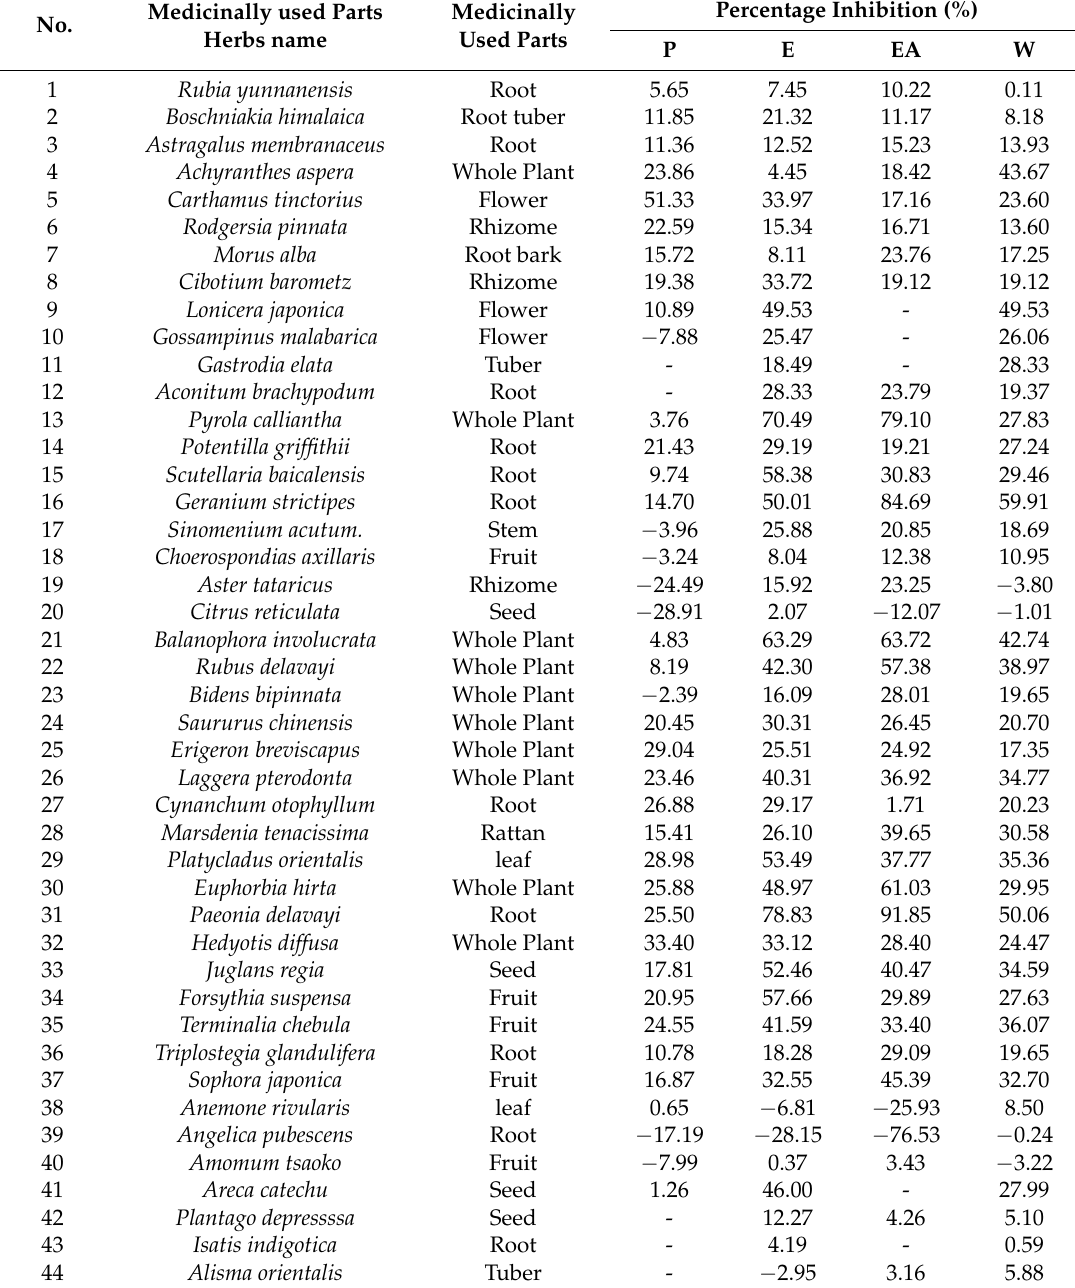
Table 1. Effects of selected traditional Chinese medicines (extracts) on inhibition of